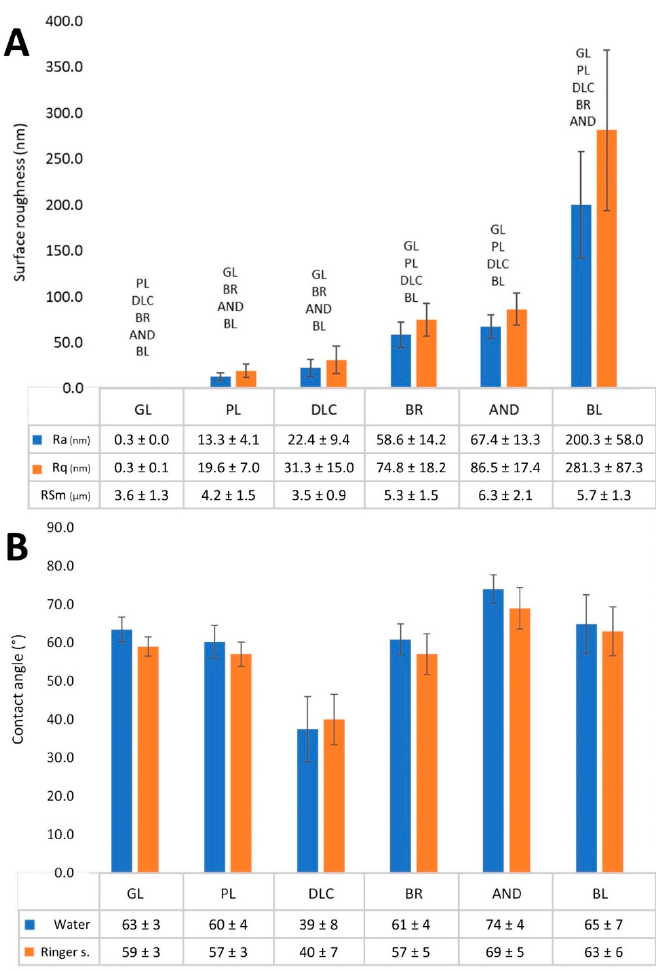
Figure 3. ( A ) Surface roughness values—average surface roughness (Ra), root mean square roughness (Rq), and mean value of the width of the profile irregularities (RSm) of the reference glass coverslips (GL) and of the Ti6Al4V samples modified by polishing (PL), by DLC-coating (DLC), by brushing (BR), by anodizing (AND), or by blasting (BL). ( B ) Wettability of the samples measured by the contact angle of a sessile drop of deionized water or Ringer’s solution on a freshly cleaned surface in air. Average ± SD from three samples (10 measurements on each sample), ANOVA, statistical significance p ≤ 0.05.